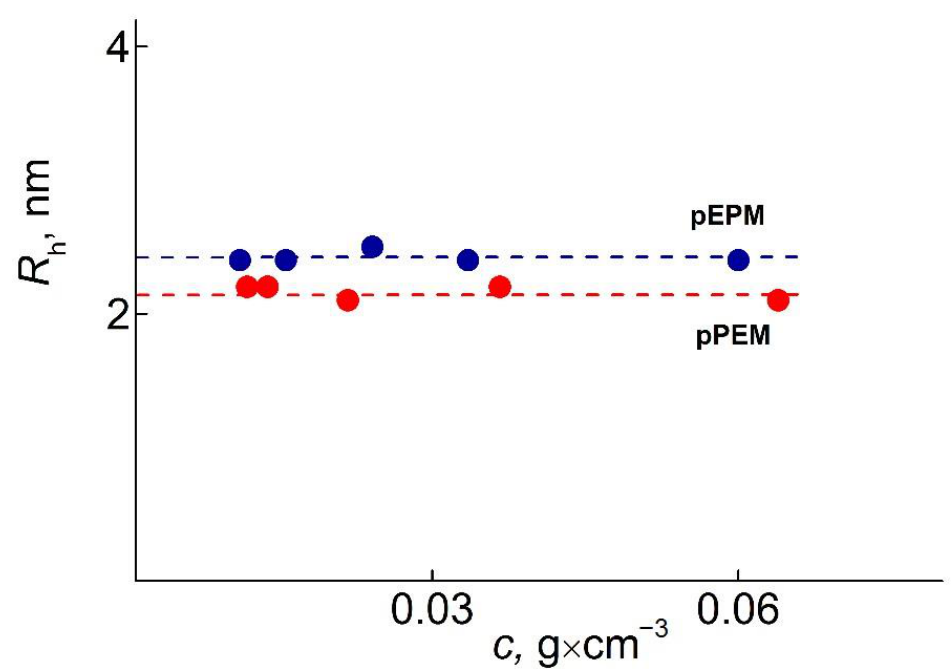
Figure 5. Concentration dependencies of radius R h-D for pEPM and pPEM in acetonitrile.